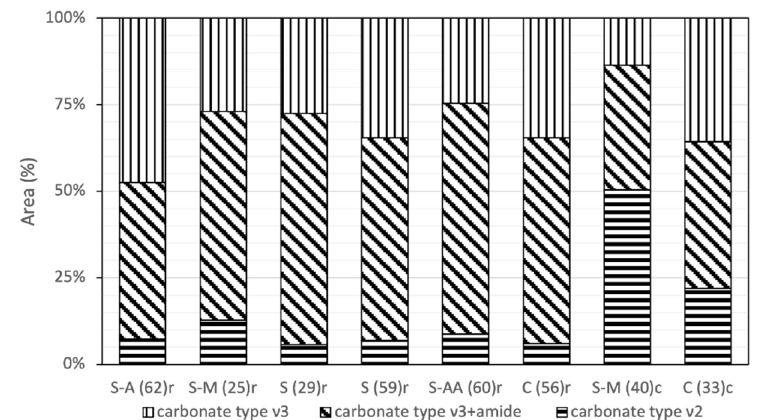
Figure 4. Area of carbonate by FTIR spectra. Quantification of carbonate type ν 2 (850–890 cm − 1 ), ν 3 (a1350–1450 cm − 1 ), and “carbonate type ν 3 +amide” (1450–1600 cm − 1 ). The samples of crown enamel are labeled as "c", and those of root cementum as "r". The conditions of patients' teeth are indicated as follows: alcohol (A); smoker (S); treatment with psychotherapeutic drugs (M); anti ‐ inflammatory drugs (AA); control (C). The age of each patient is shown in parentheses.